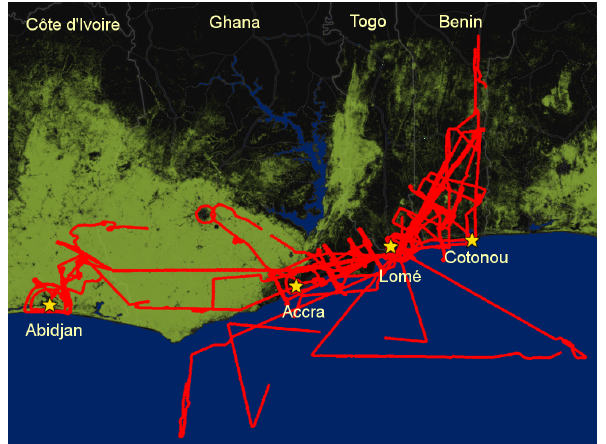
Figure 1. ATR42 trajectories (in red) during DACCIWA for al- titudes below 2000m overlaid the forest cover (in green), non- forested areas (black) and water surface (blue). Forest cover data are from Hansen et al.